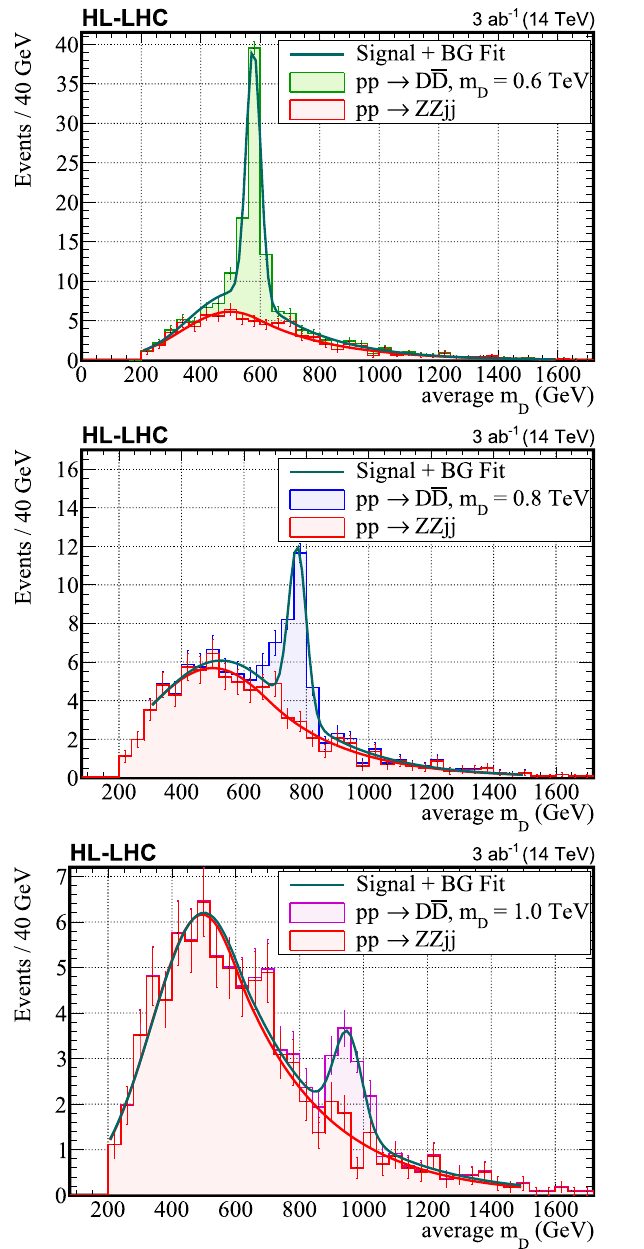
Fig. 8 Distribution of average reconstructed D quark invariant mass ( m + m )/ 2 forFCC-hhconditions forbackground andsignalswith D 1 D 2 m D = 800 GeV (top), 1600 GeV (middle) and 2500 GeV (bottom). Results of the fit to the sum of a Gaussian and Crystal Ball functions are also